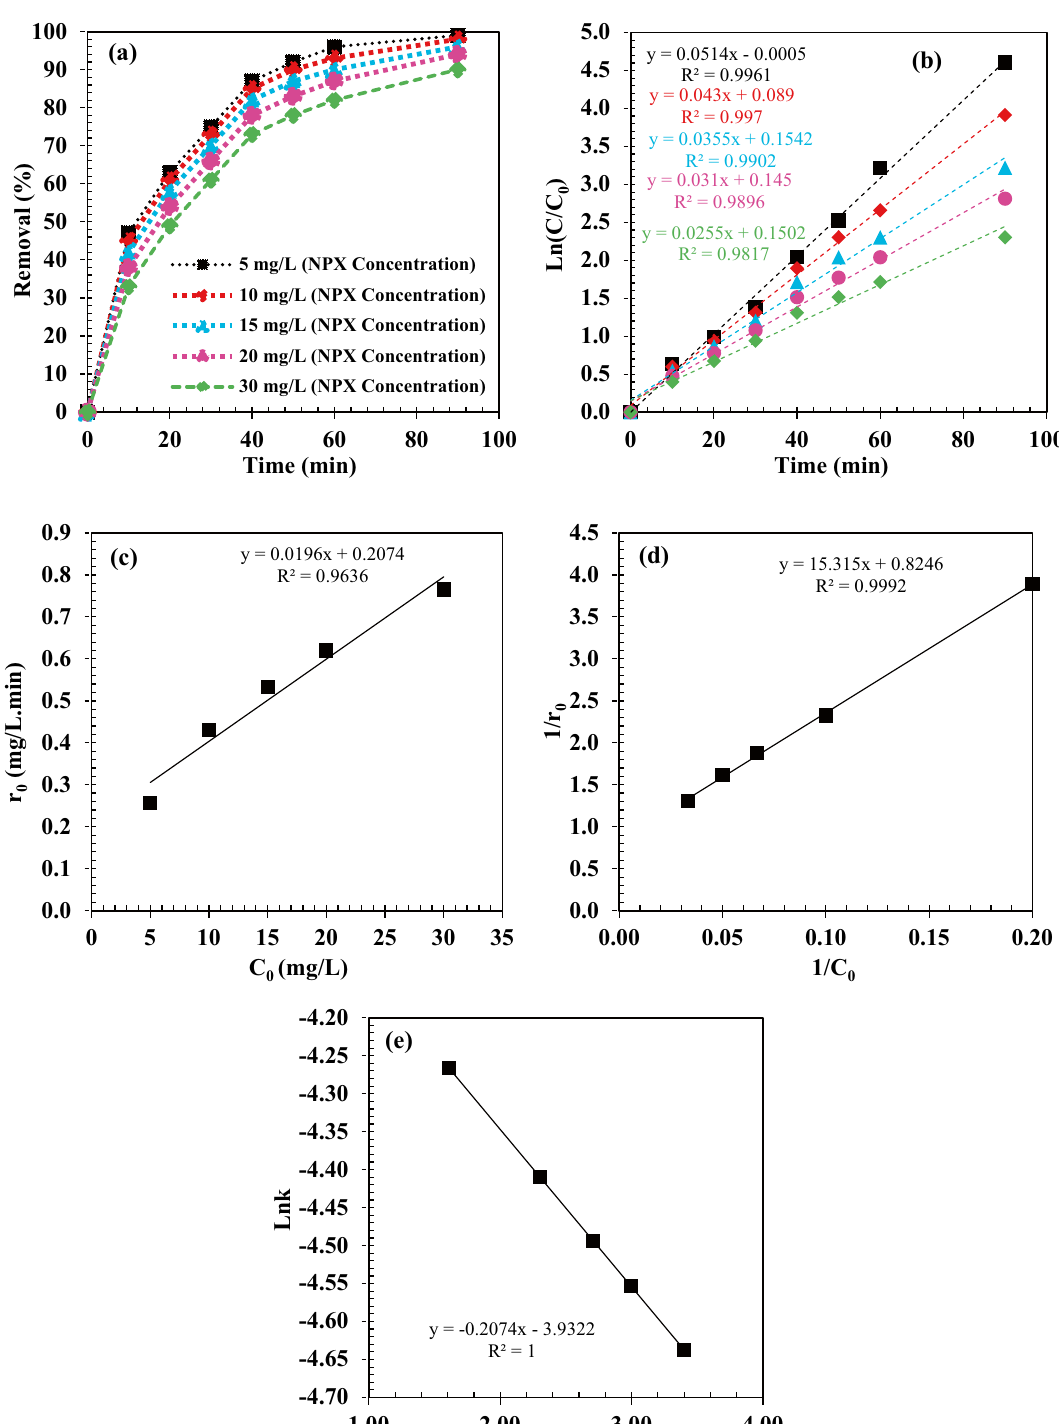
Figure 14. ( a ) The effect of initial concentrations on NPX removal(%), ( b ) The effect of initial concentrations of NPX on photo degradation, ( c ) The initial reaction rate (r 0 ) as a function of NPX initial concentration (C 0 ); ( d ) L–H model of photocatalytic NPX degradation by ZrO 2 /TiO 2 /Fe 3 O 4 ; ( e ) The effect of different initial concentrations on the NPX photo degradation rate